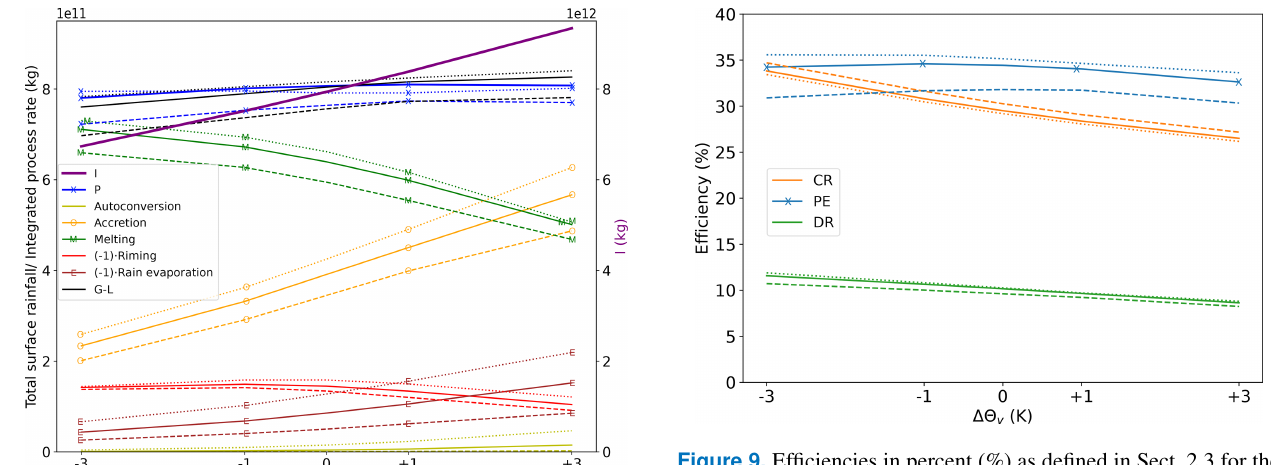
Figure 9. Efficiencies in percent (%) as defined in Sect. 2.3 for the PB- T -CCN simulations. Values at three different CCN concentra- tions n CCN = 200cm − 3 (dotted), 500cm − 3 (solid) and 1500cm − 3 (dashed) are plotted over (cid:49)(cid:50) v . Colours indicate the condensa- tion ratio (orange), precipitation efficiency (blue), and drying ratio